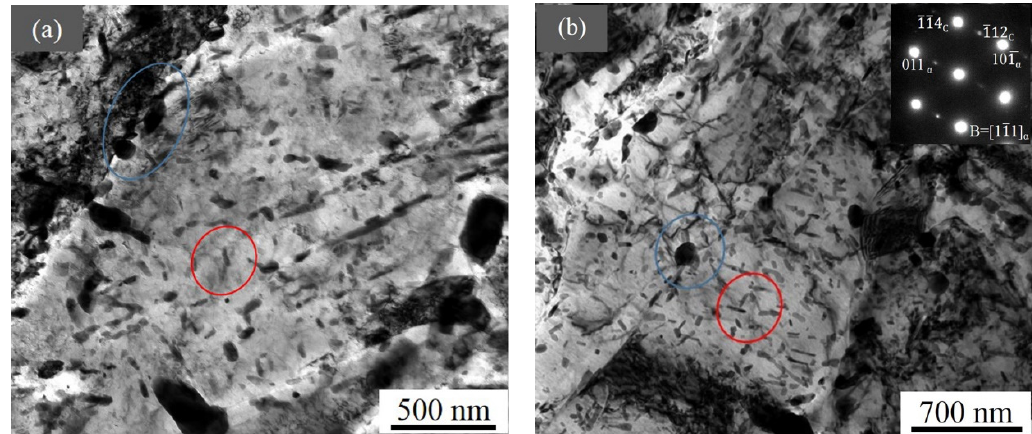
Figure 7. ( a ) TEM image of the nitrided steel at the depth of 120 µm. The white lines indicate the plate- like precipitates along the boundaries, and the corresponding SAED is shown in ( b ). ( c ) TEM image of the nitrided steel at the depth of 210 µm, as well as ( d ) corresponding SAED. In ( c ), the blue circle marks the Fe 3 C, the red one indicates GP zones and CrN, and their diffraction spots are seen in ( d ).